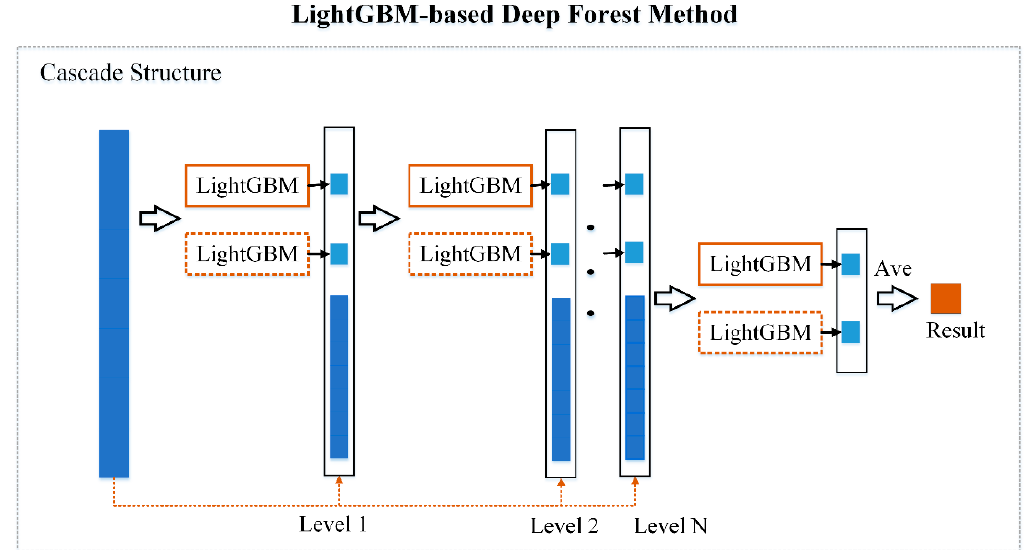
Figure 2. Flowchart for the LGB-DF model.